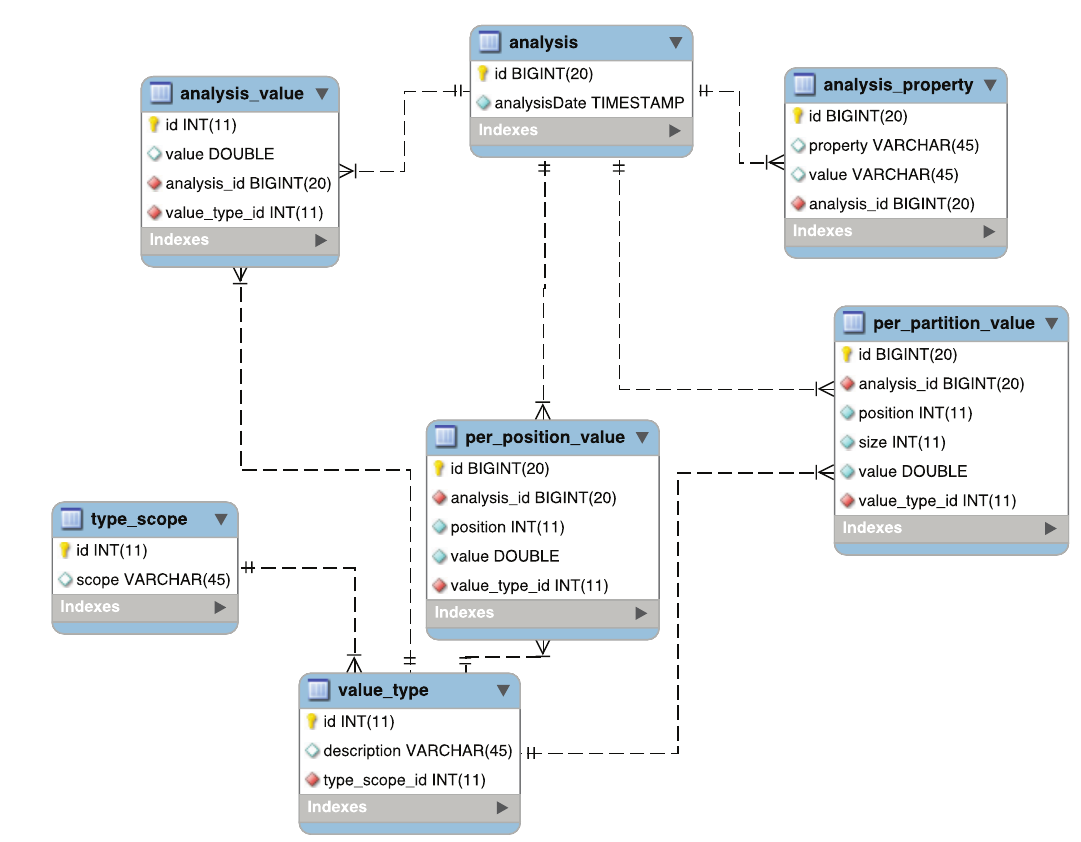
Figure 2. StatsDB database